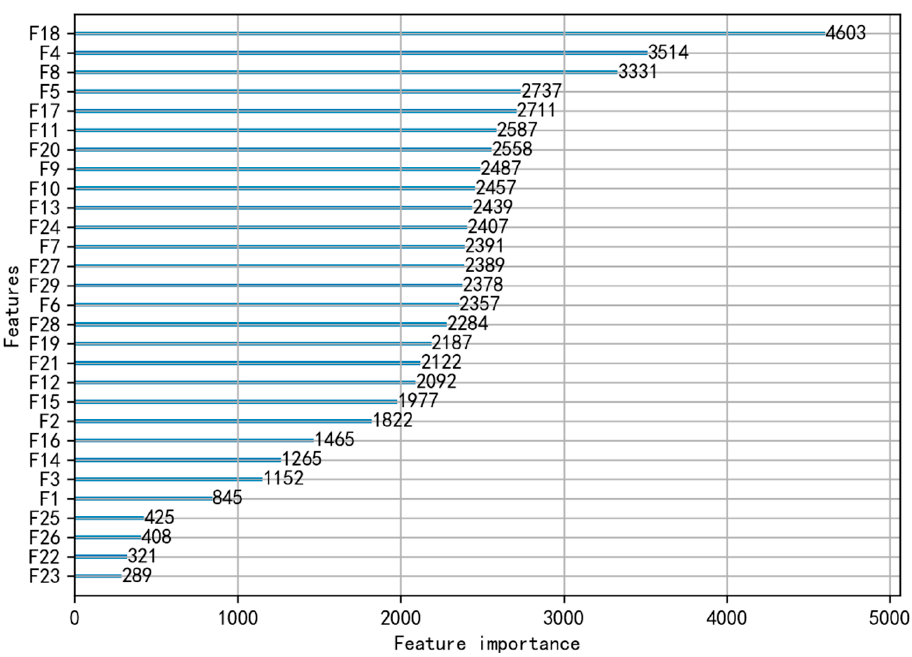
Figure 4. Feature importance identification results (quantified importance for the 29 meteorologi- cal variables, the last six variables being the least important, including {F1, F16, F22, F23, F25, F26}).